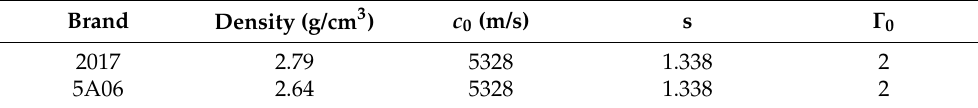
Table 2. Material properties of state equation.